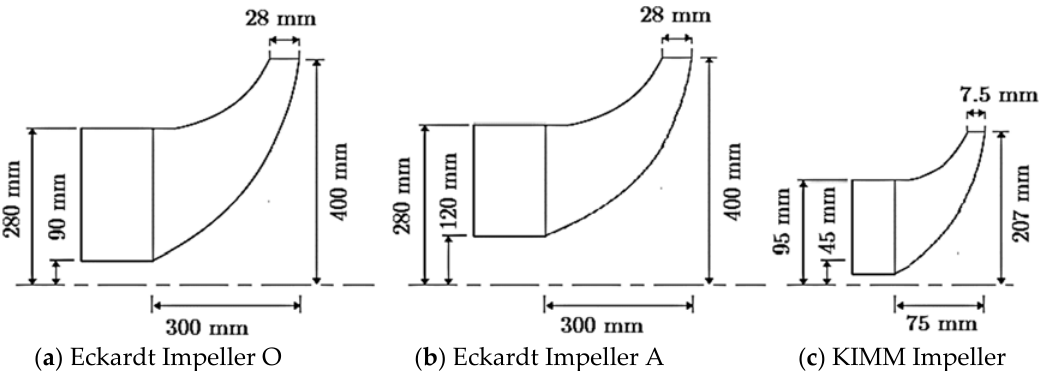
Figure 4. Impeller geometries considered for the validation (not in scale) [23]. ( a ) Eckardt impeller O. ( b ) Eckardt impeller A. ( c ) KIMM impeller.